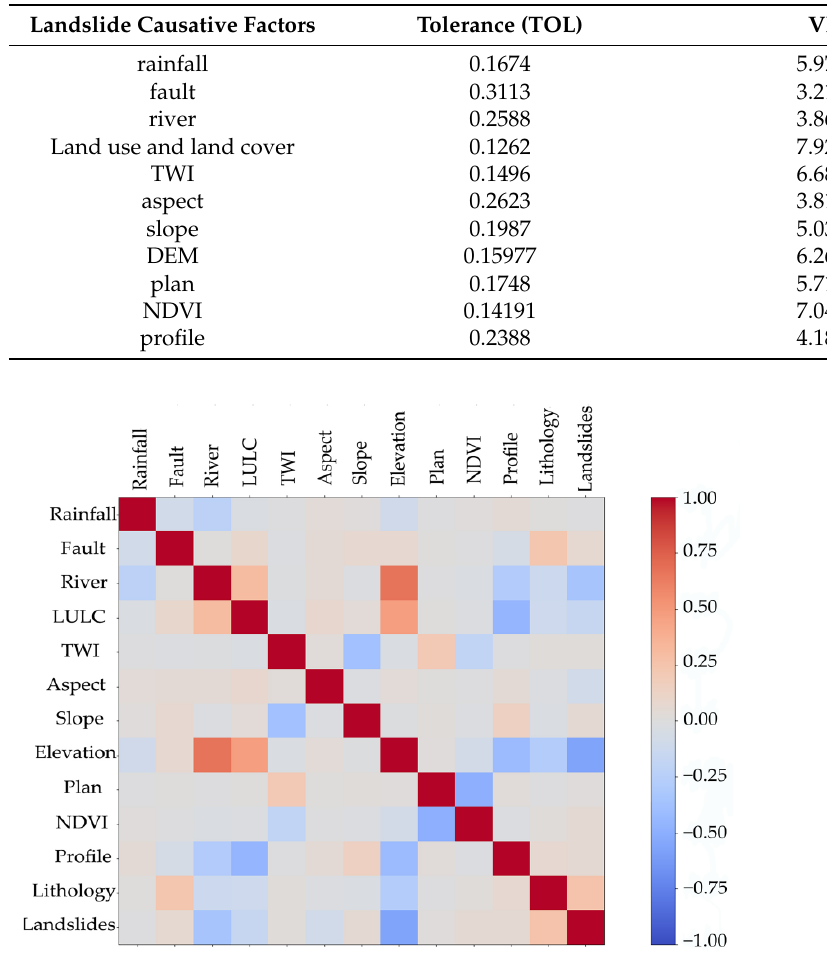
Table 3. Multi-collinearity analysis of landslide causative factors.